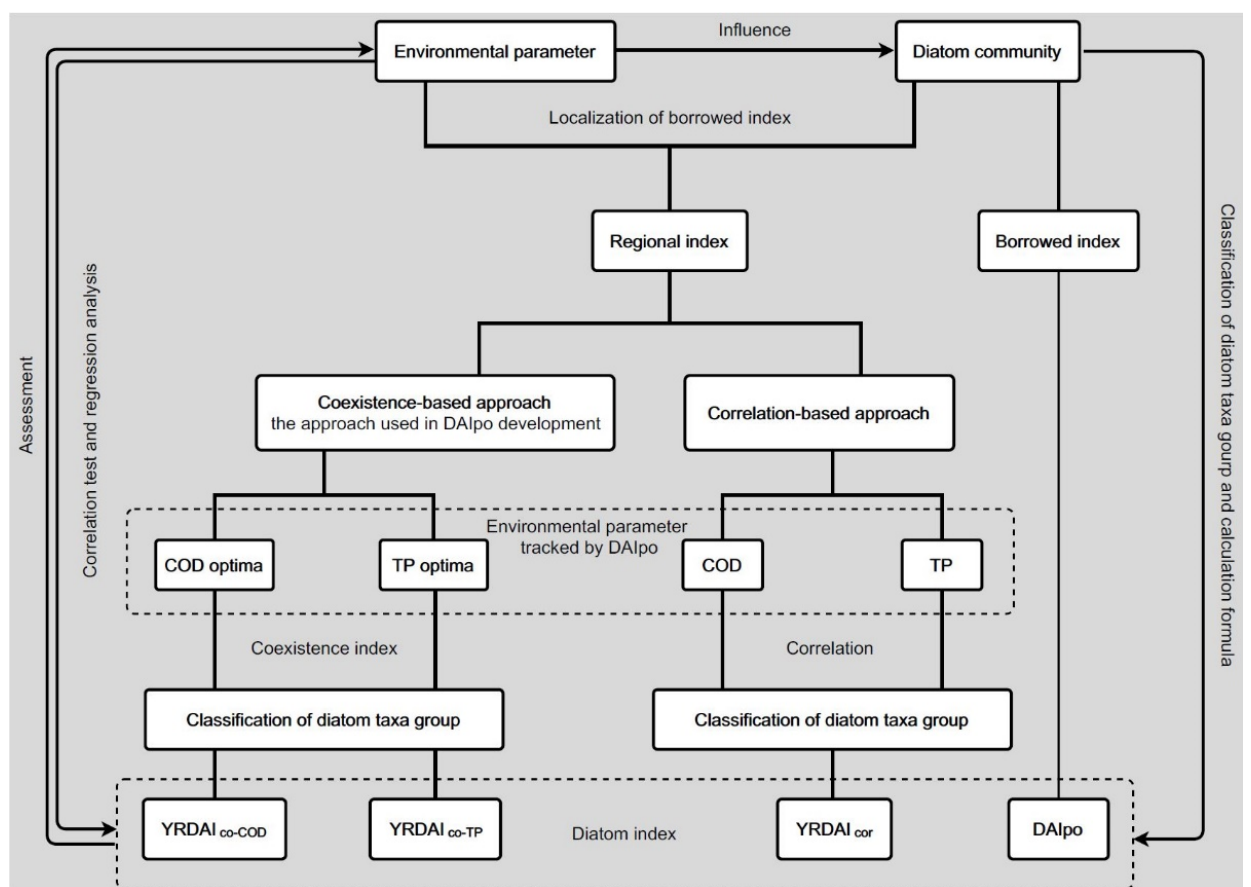
Figure 1. Flow chart for creating a regional diatom index (YRDAI).